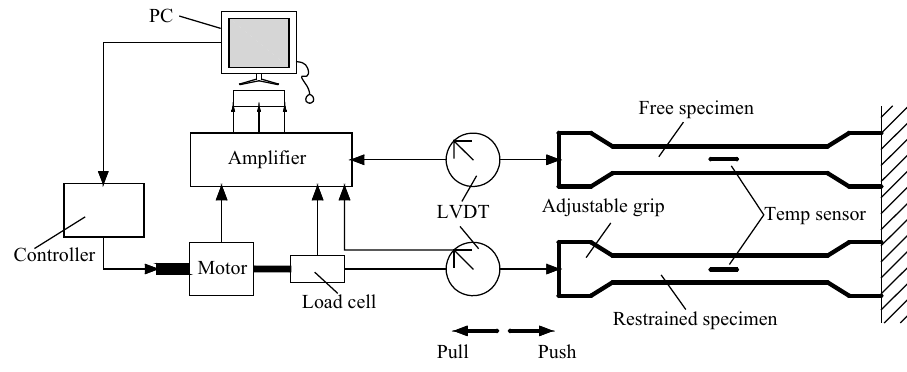
Figure 2: Schematic diagram of the TSTM system [ 22 ]